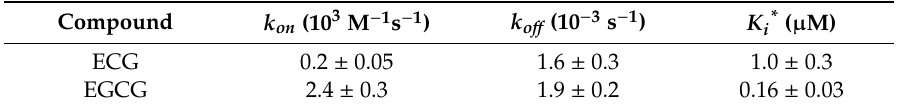
Table 1. Summary of true affinity and binding kinetics of epicatechin gallate (ECG) and